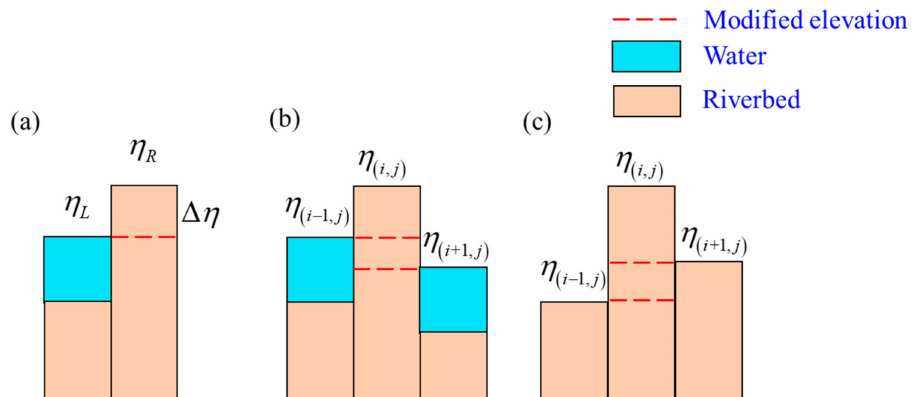
Figure 1. The traditional elevation modification of wet-dry front. ( a ) Modify elevation to the same as wet cell; ( b , c ) Two times elevation modification of one dry